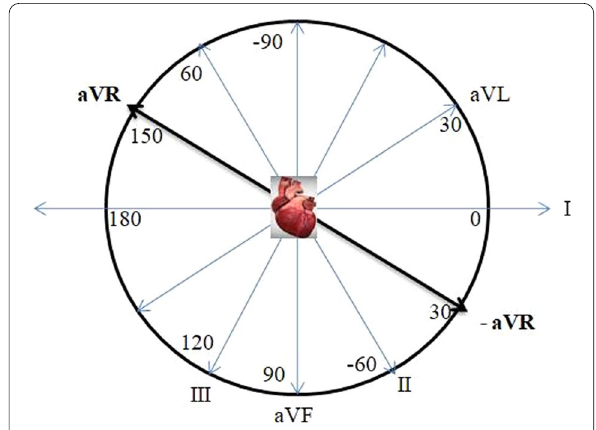
Fig. 4 Diagram of the limb leads within the frontal plane in the Cabrera